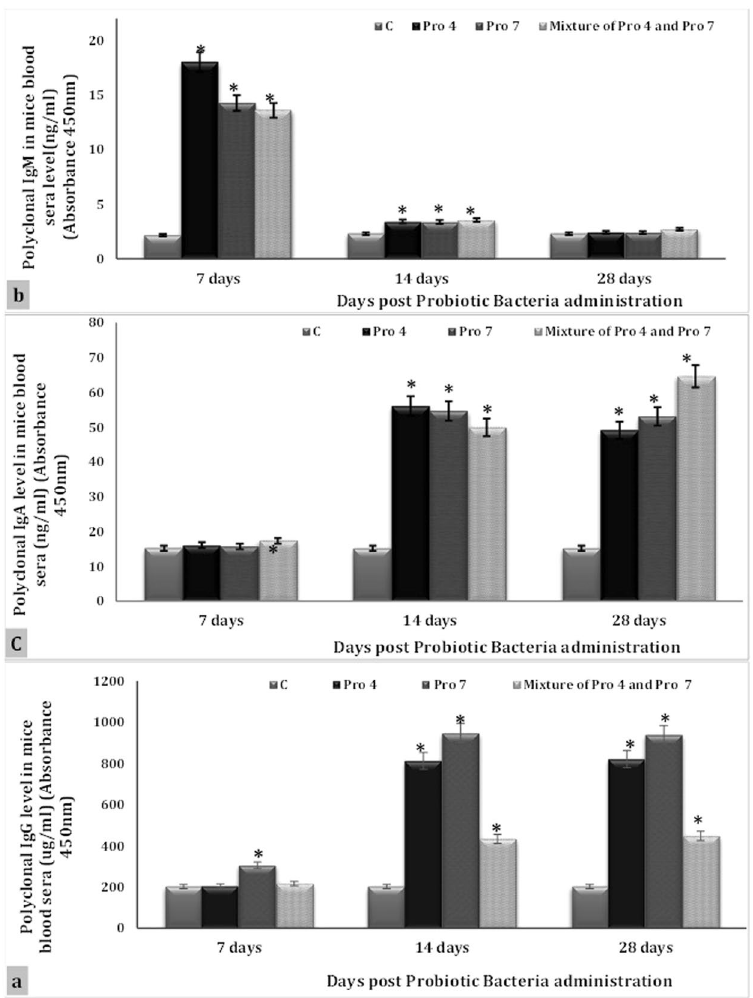
Figure 7. Profile of total serum Immunoglobulins in sera of all mice groups following administration of probiotic bacteria. ( a ) Level of polyclonal IgG, ( b ) Level of polyclonal IgM, and ( c ) Level of polyclonal IgA. Where C represented untreated group, Pro 4 represent group treated with Lactobacillus paracasei/casei , Pro 7 represent group treated with Lactobacillus rhamnosus and a mixture of Pro 4 and Pro 7 represent group treated with a mixture of 1:1 from Lactobacillus paracasei/casei and Lactobacillus rhamnosus . ( * ) Significant at p < 0.05 as determined by analysis of variance, comparison was performed using One factor ANOVA test. ( * ) Comparison between controls and tested group. ( * ) Comparison between the treated groups. Every point represents the mean value of three separate tests and the vertical bars denote the 5% percentage around the